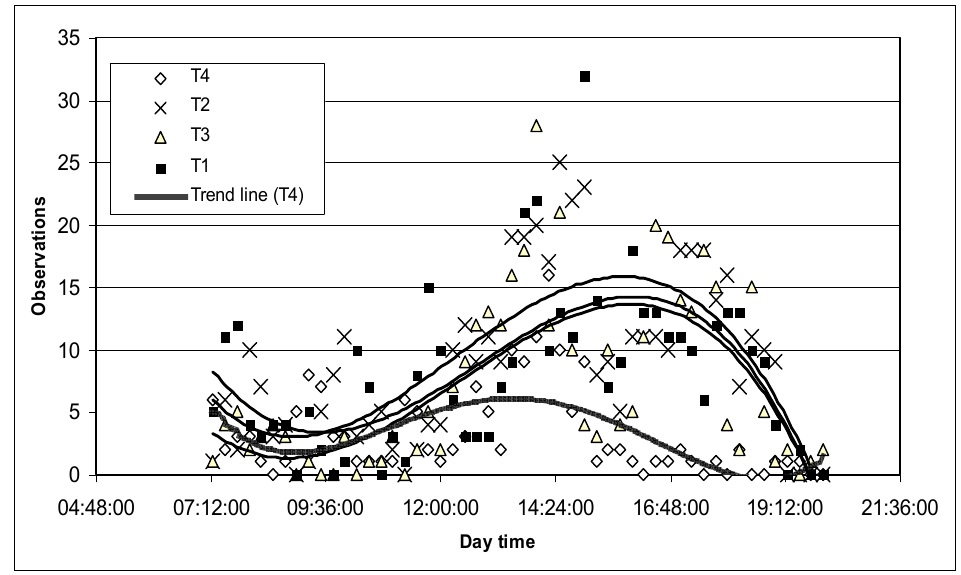
Figure 9. Ruminating frequency and distribution during daytime by treatment. Walking. Walking frequencies were not different in T3, T2, and T1 and were all Lying or standing . Animals from T3 spent more time lying or standing, with inter- mediate values for T2 and lower values for T1. Animals from T4 spent more time than pasture-based treatments lying or standing (LorS; Figure 7). However, as confined ani- mals had fewer choices available and several behavior patterns were suppressed, it would be a subjective criterion to categorize these behaviors as “resting” in T4. These results could probably mainly be explained by their spatial restrictions.